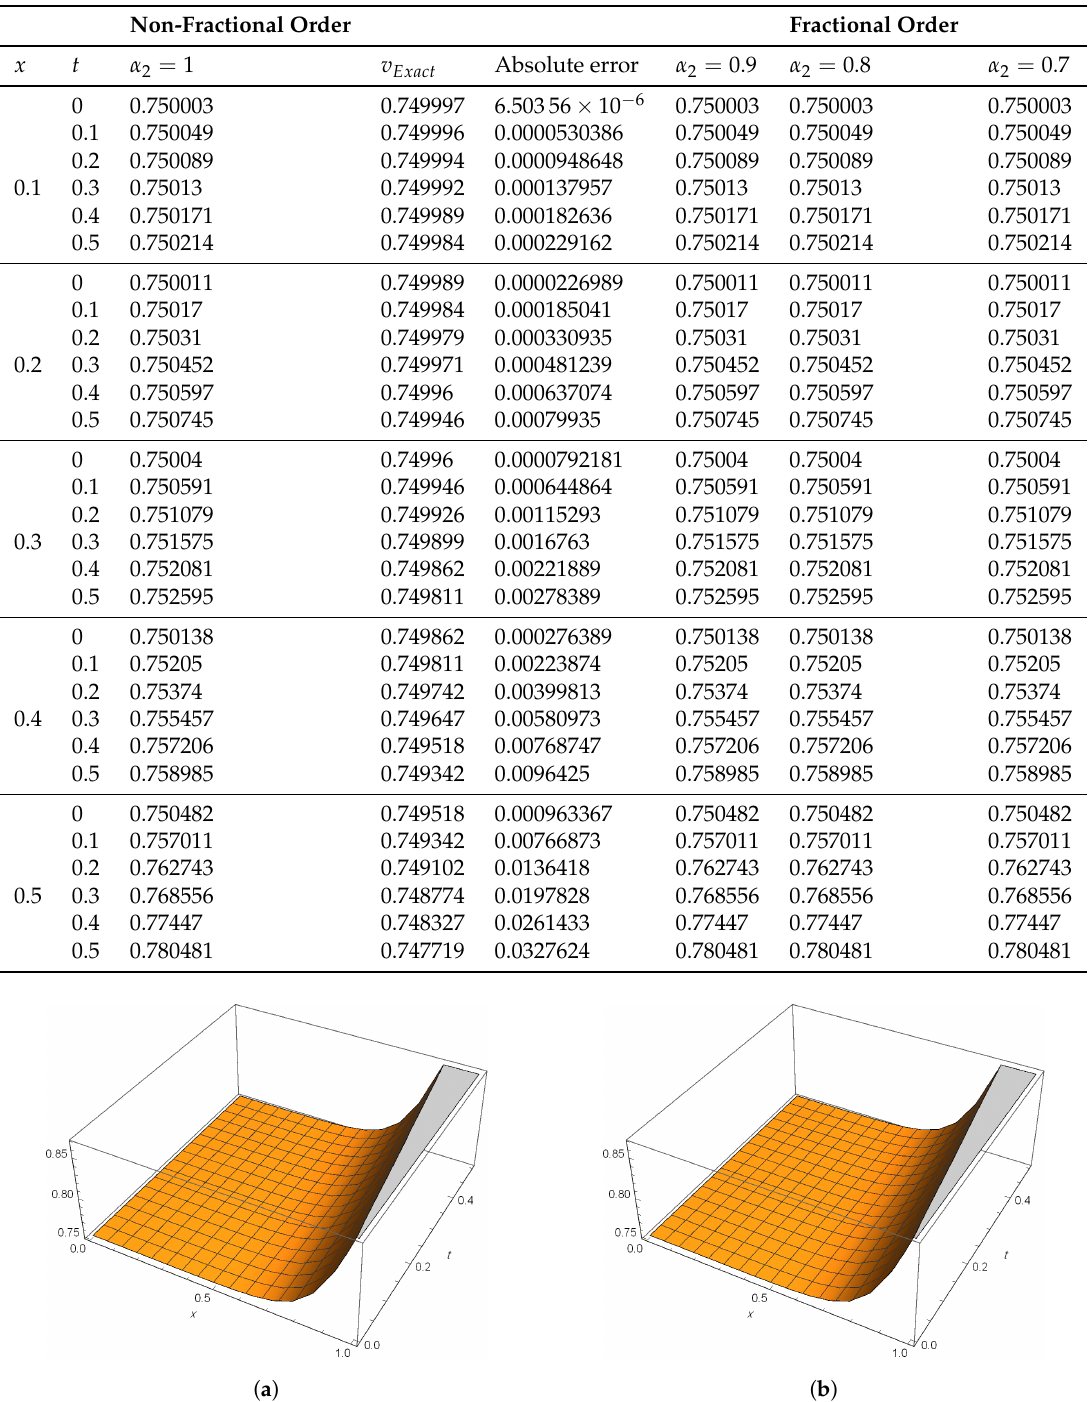
Table 5. Fourth order numerical approximate solutions of v 4 ( x , y , t ) by FRDTM at different values of α 2 and comparison of absolute errors at α 2 = 1, y = 1 and R = 100.